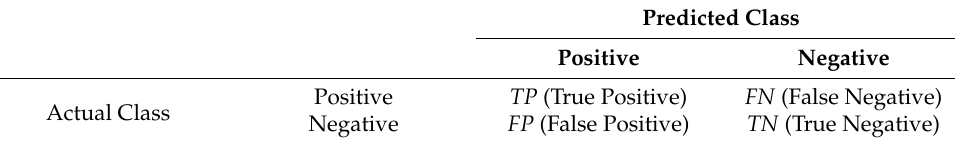
Table 1. Confusion